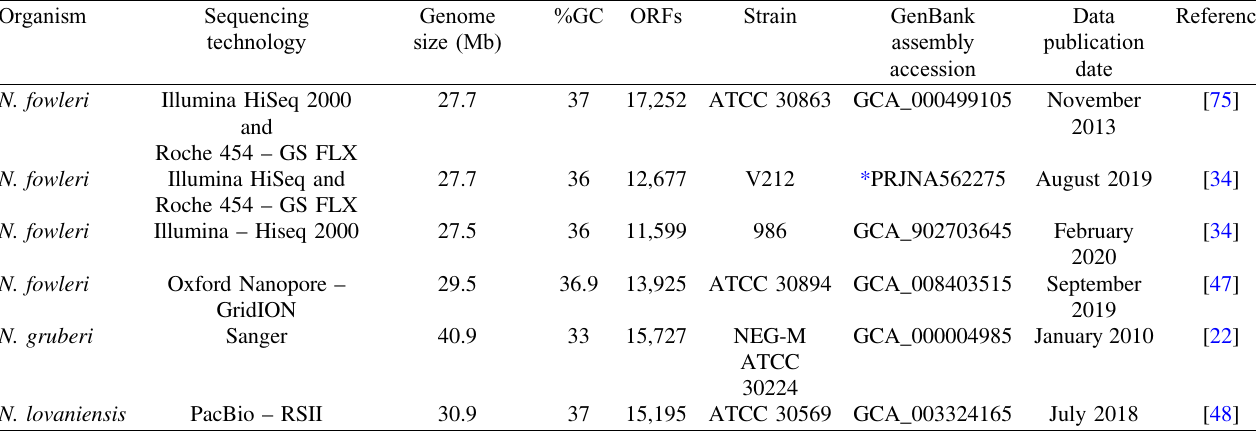
Table 2. Data from the assembled genomes of Naegleria spp.